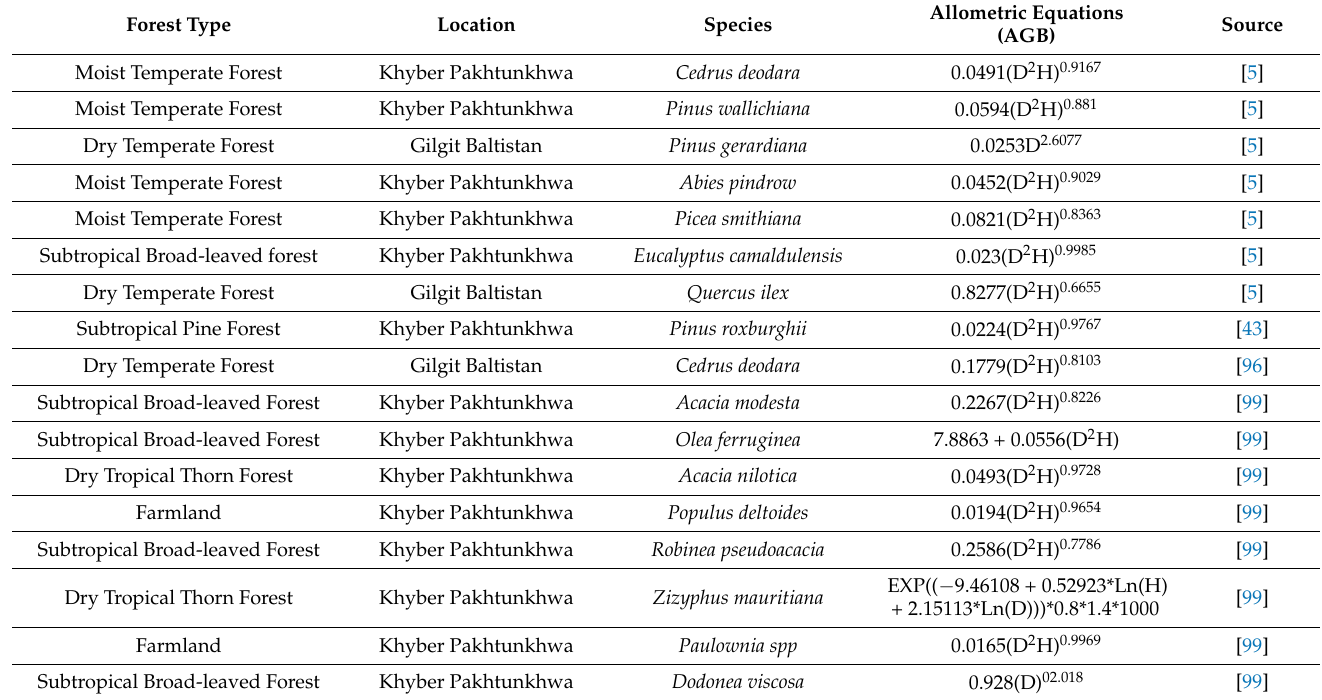
Table 4. Allometric equations of Pakistan forest ecosystem.